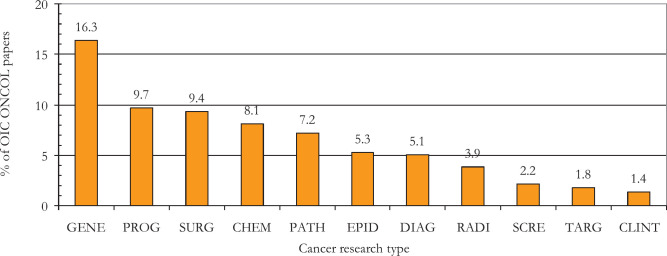
Percentages of OIC countries’ cancer research, 2008–17, in 12 domains. GENE = genetics; PROG = prognosis; CHEM = chemotherapy; SURG = surgery; PATH = pathology; EPID = epidemiology; DIAG = diagnosis; RADI = radiotherapy; SCRE = screening; CLINT = clinical trials.; PALL = palliative care; QUAL = quality of life.